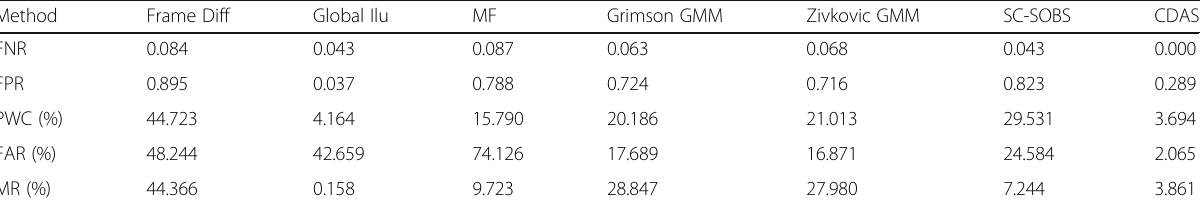
Table 4 Comparison results with the hand-labeled dataset when the brightness changes Method